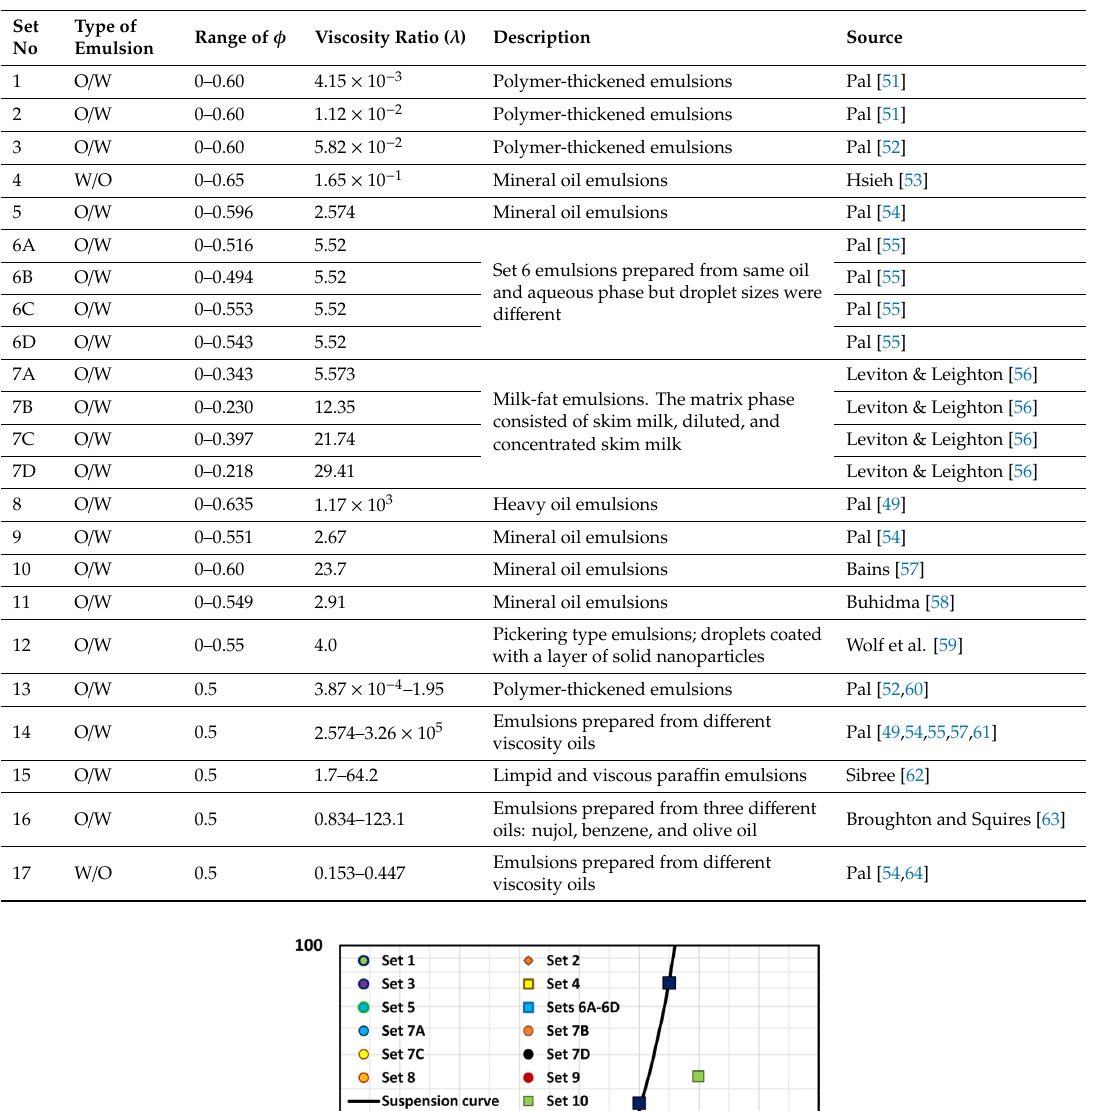
Table 4. Summary of various emulsion systems considered in evaluating the viscosity models.